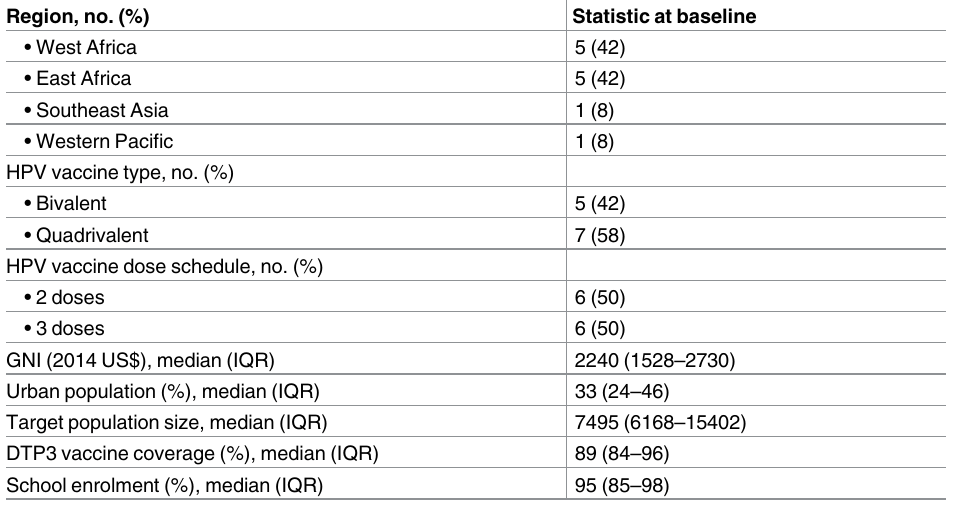
Table 2. Baseline characteristics of demonstration project countries.